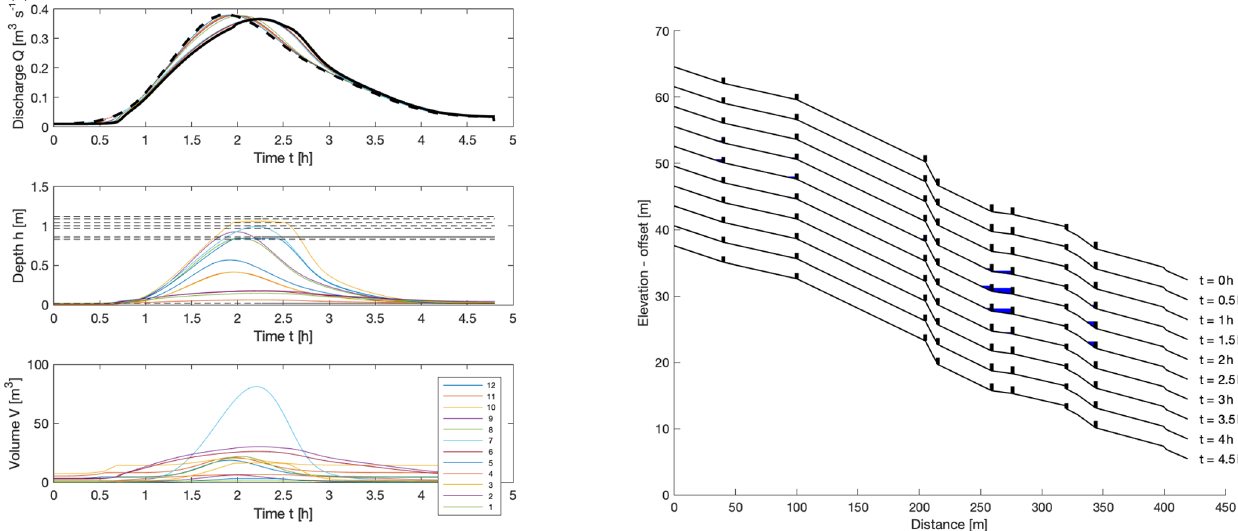
Figure 12. Model run using the given measured dam locations and bottom height of 0.02m. Note that each segment has a different width, which is not shown on the diagram, but which can lead to different rates of filling of the region behind different dams. We take a Manning roughness of 0.1sm − 1 / 3 . The reduction peak discharge is 96% of the inflow, and the maximum volume stored is 245m 3 .